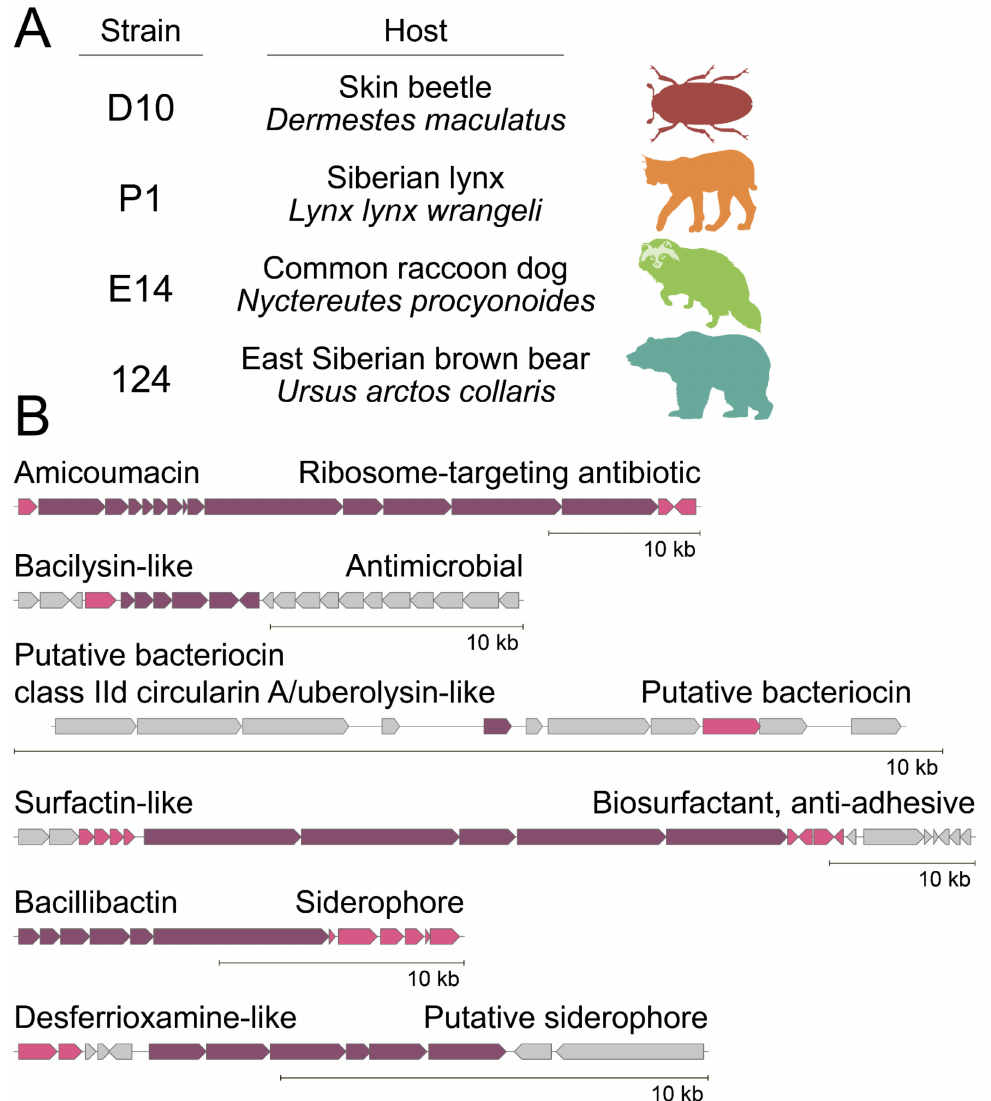
Figure 2. Representative B. pumilus strains isolated from different wild hosts. ( A ) Summary of their origin and ( B ) a common set of BGCs encoding Ami, siderophore bacillibactin, and putative analogs of antimicrobials including bacilysin, class IId cyclical bacteriocin, surfactin, and desferrioxamine. Core BGC proteins and related genes (transporters, resistance, and modifying enzymes) are colored with violet and pink, respectively. Scale bar: 10